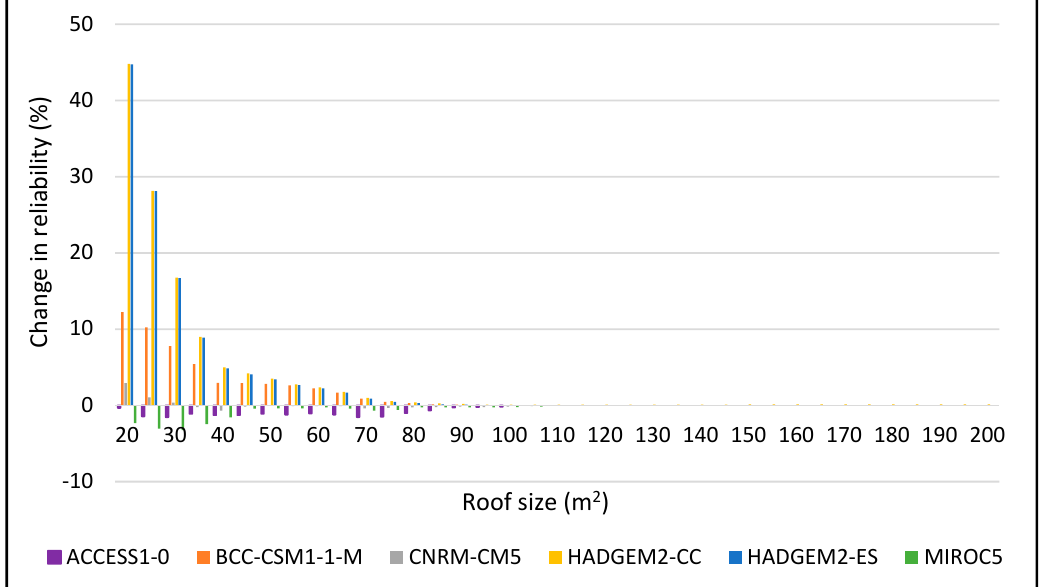
Figure 35. Change in reliability for SON season for 2060–2090 period for 5 m 3 tank.